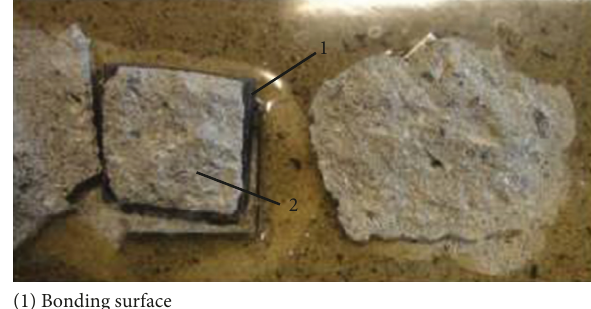
Figure 9: The bonding surface remained intact, and the concrete was